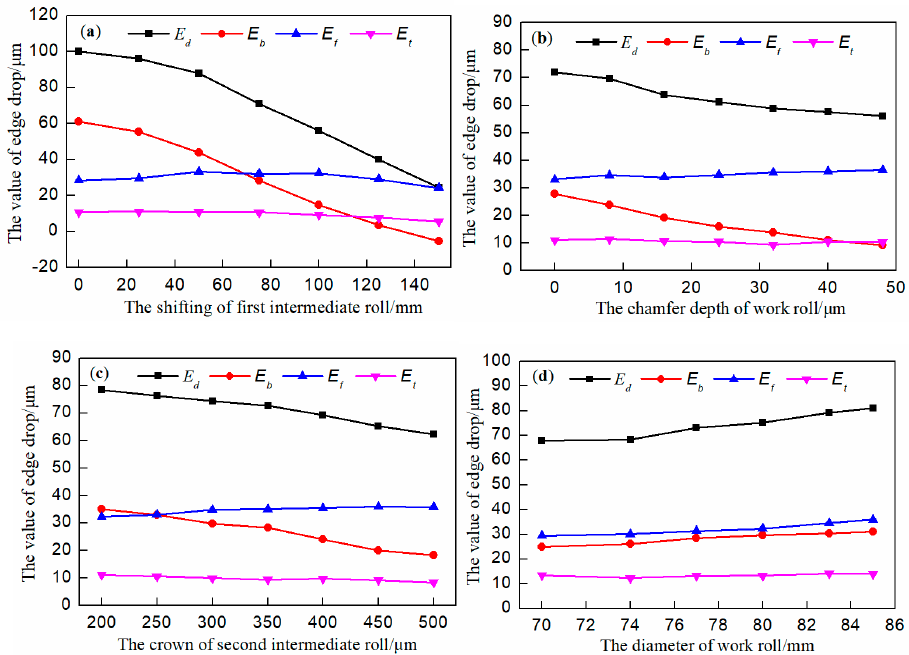
Figure 10. The effect of roll contour configuration on edge drop: ( a ) The shifting of the first intermediate roll; ( b ) the chamfer depth of the work roll; and ( c ) the crown of the second intermediate roll; ( d ) the diameter of the work roll.